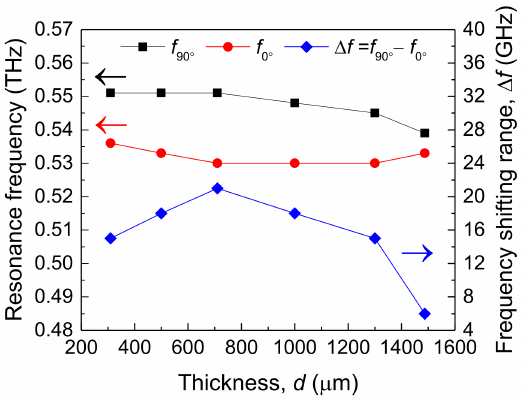
Figure 7. Dependences of f 0 ◦ , f 90 ◦ , and ∆ f on d = 310 µ m, 500 µ m, 710 µ m, 1000 µ m, 1300 µ m, and 1487 µ